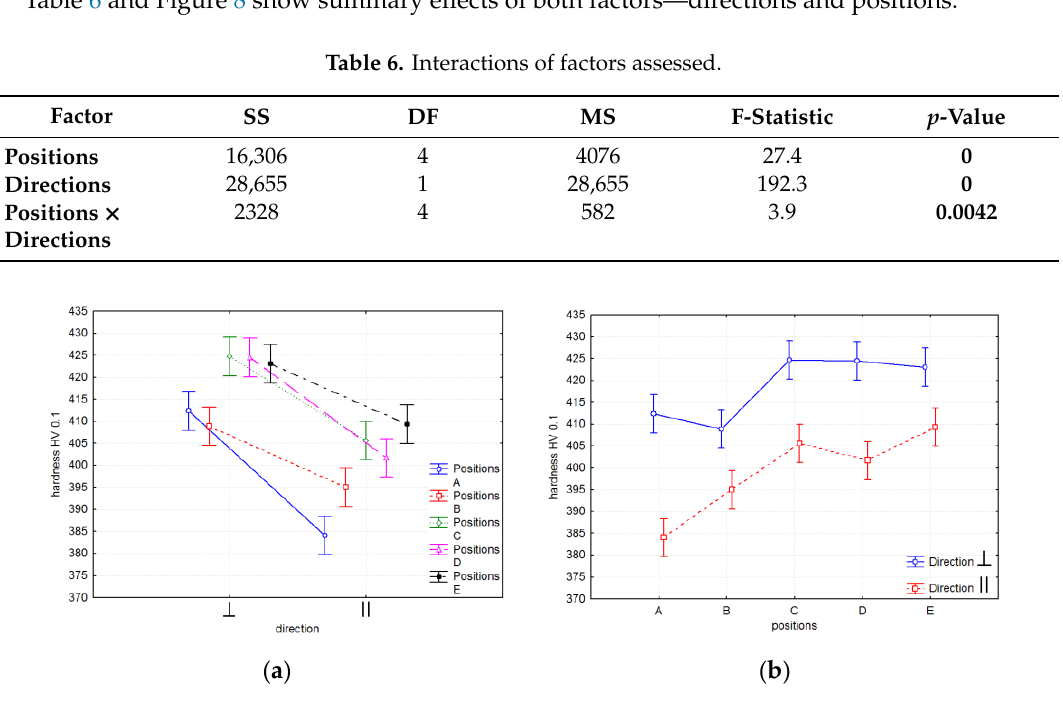
Figure 8. Interaction plots for both factors, ( a ) direction vs. hardness, ( b ) positions vs. hardness. As p < α , both factors have a statistically significant effect on material hardness.